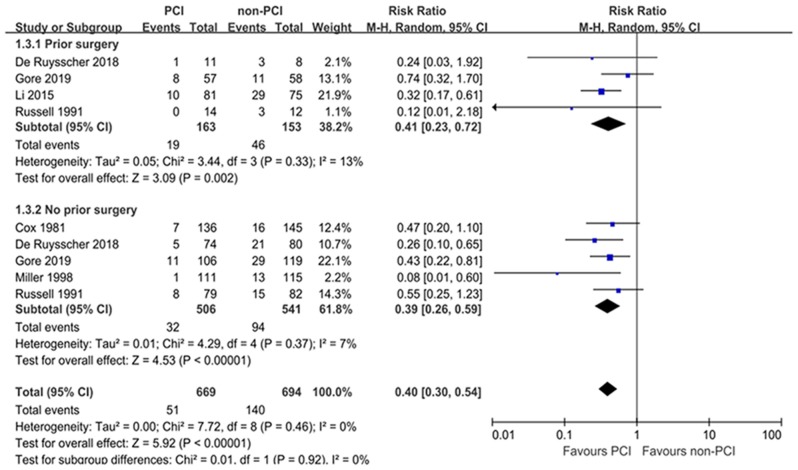
Subgroup analyses for BM according to prior treatment.